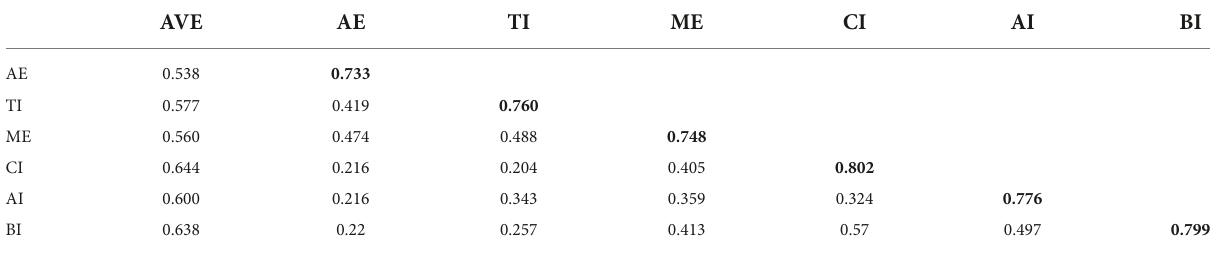
TABLE 4 Discriminant validity.